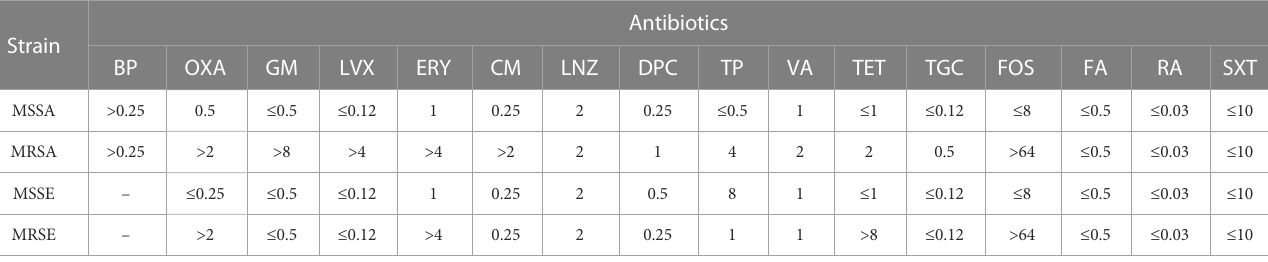
TABLE 2 Antimicrobial resistance pro fi le of Staphylococcal strains.